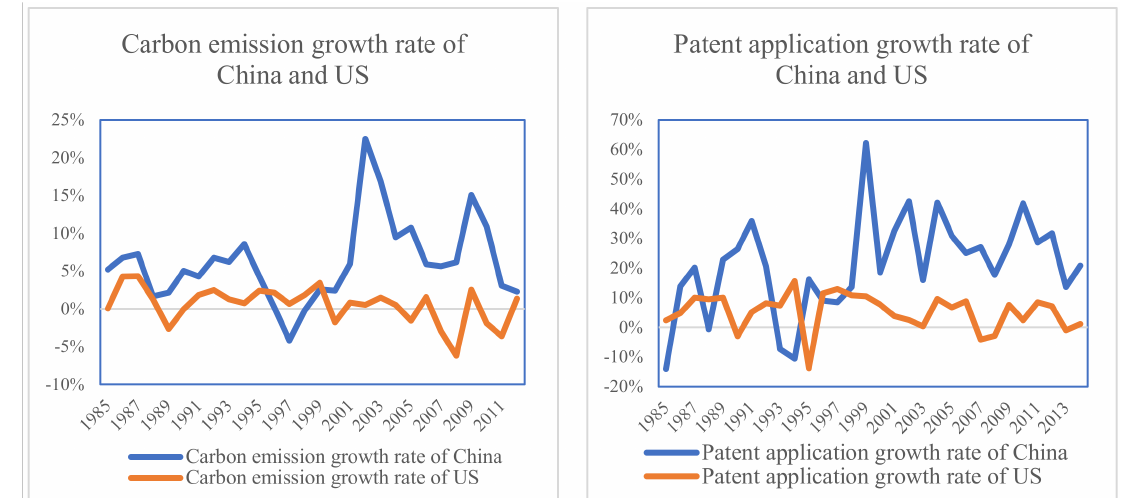
Figure 1. Trends of the growth rate of technological progress and carbon emission in China and the United States. Data source: Calculated by the author using data from the WDI